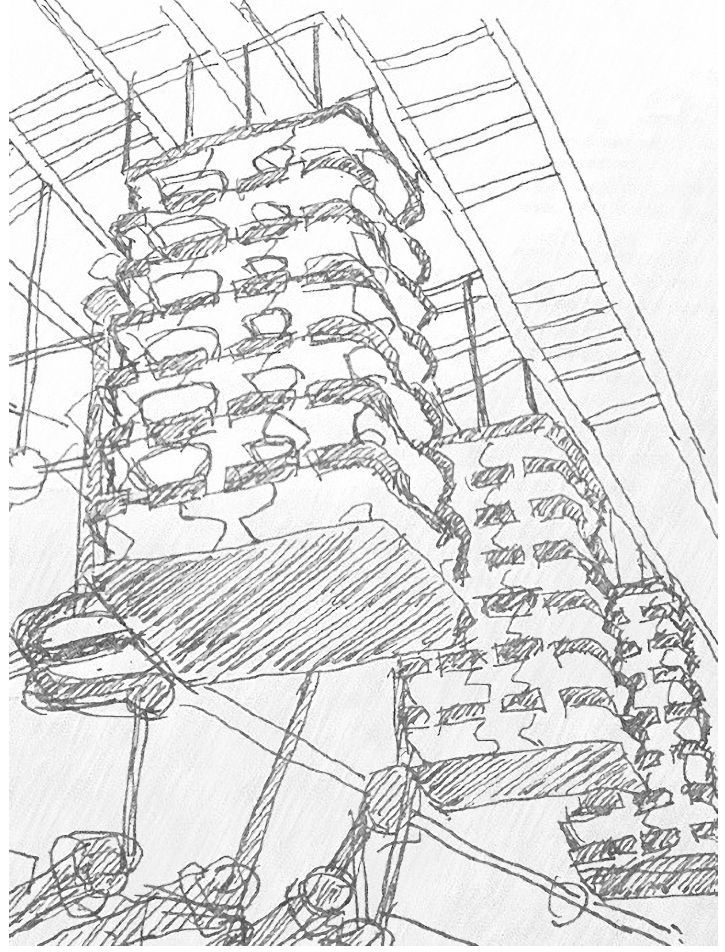
Figure 2. Schematic diagram of valve hall